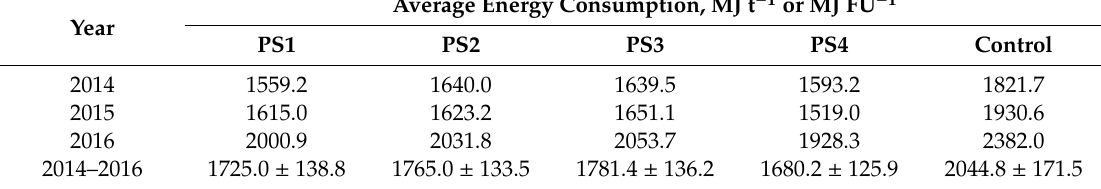
Table 4. Effect of pod sealant on total (direct and indirect) energy consumption (MJ t − 1 ) in 2014, 2015, and 2016.